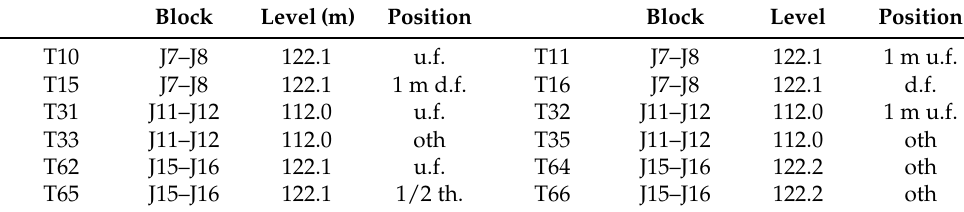
Table 1. Relative location of the thermometers in the dam